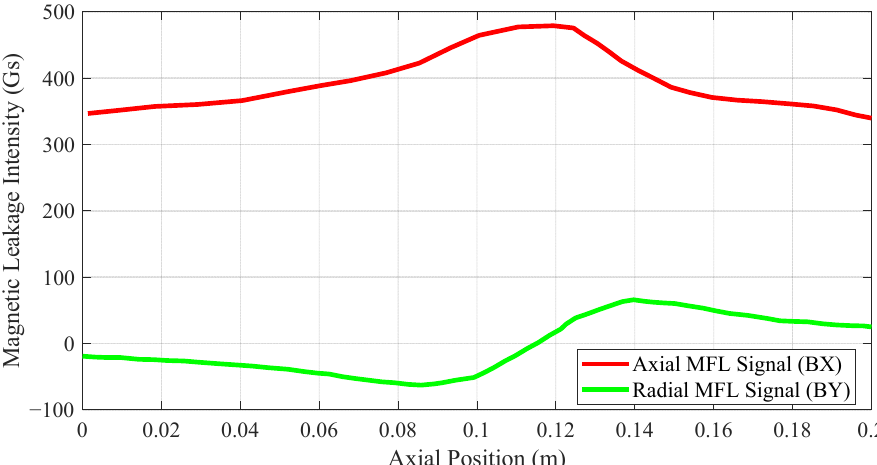
Figure 4. Axial and radial magnetic flux leakage signal of FEM simulation.